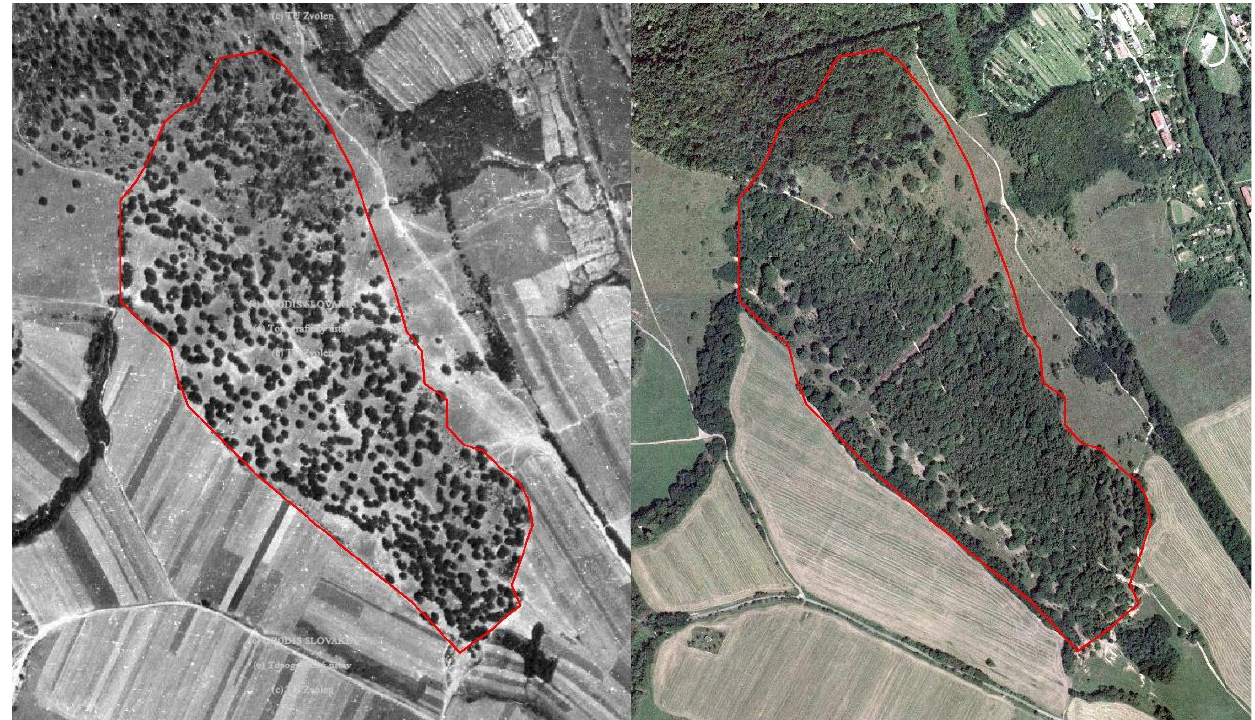
Figure 5. Comparison of historical wood pasture with present situation typified by excessive woody species encroachment because of the long-term cessation of grazing at the locality of Katarínska Huta, Central Slovakia. Even after 70 years, the veteran core trees are present at the locality and represent a potential for effective restoration of historical structure. Historical orthophotomap © GEODIS SLOVAKIA and historical aerial imagery © Topographic Institute Banská Bystrica, ortophotomap © EUROSENSE, GEODIS Slovakia.